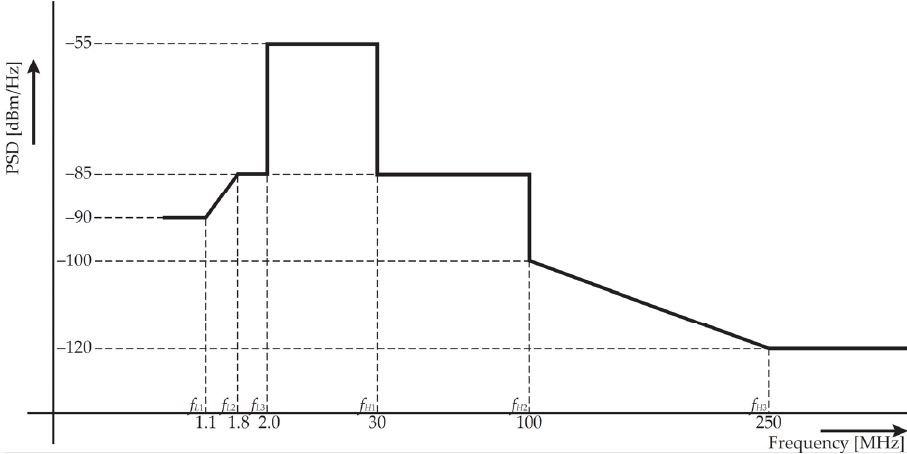
Figure 1. Transmission power regulation according to specification G.9964.